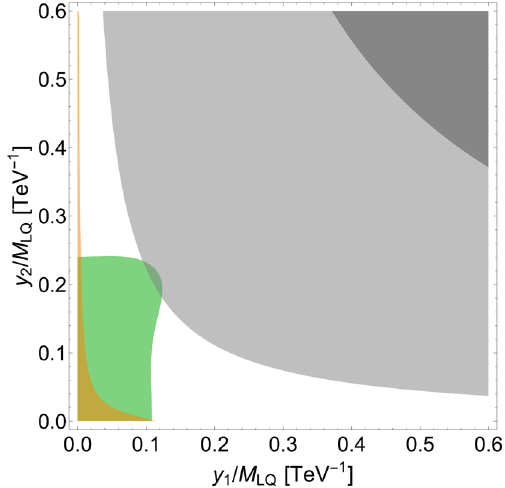
Fig. 4 Constraints on the parameters of the S 1 – R 2 leptoquark model with the cubic interactions in Eq. (4.5). We show the region preferred at 95% CL by the LHC pp → e + e − Drell–Yan data [43] (green), and by the combination of low-energy precision measurements performed in Ref. [50] (orange). We also show the region excluded by a hypothetical measurement of the D parameter in 23 Mg with the uncertainty of 10 − 4 (darker shade of gray) and 10 − 5 (lighter shade of